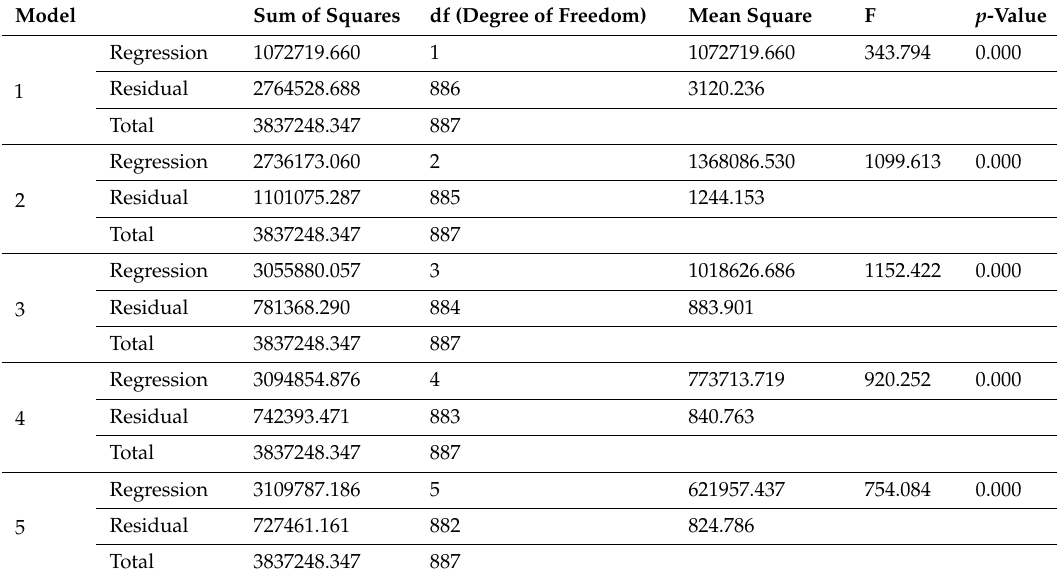
Table 8. ANOVA of the models.